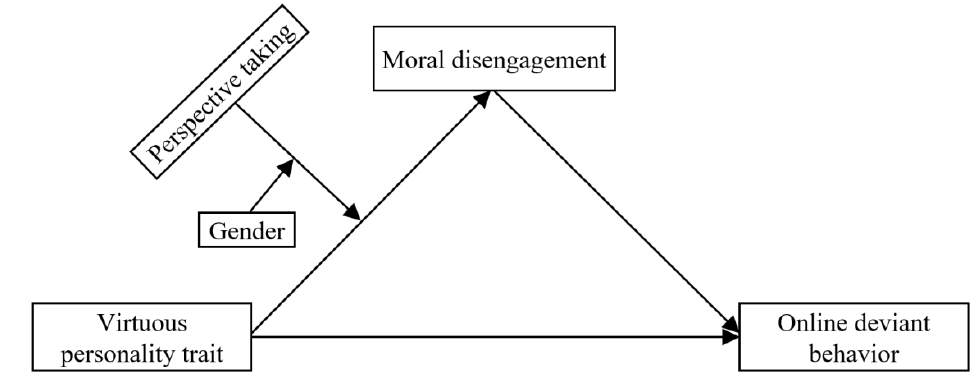
Figure 1 . The proposed moderated moderated-mediation model. Figure 1. The proposed moderated moderated-mediation